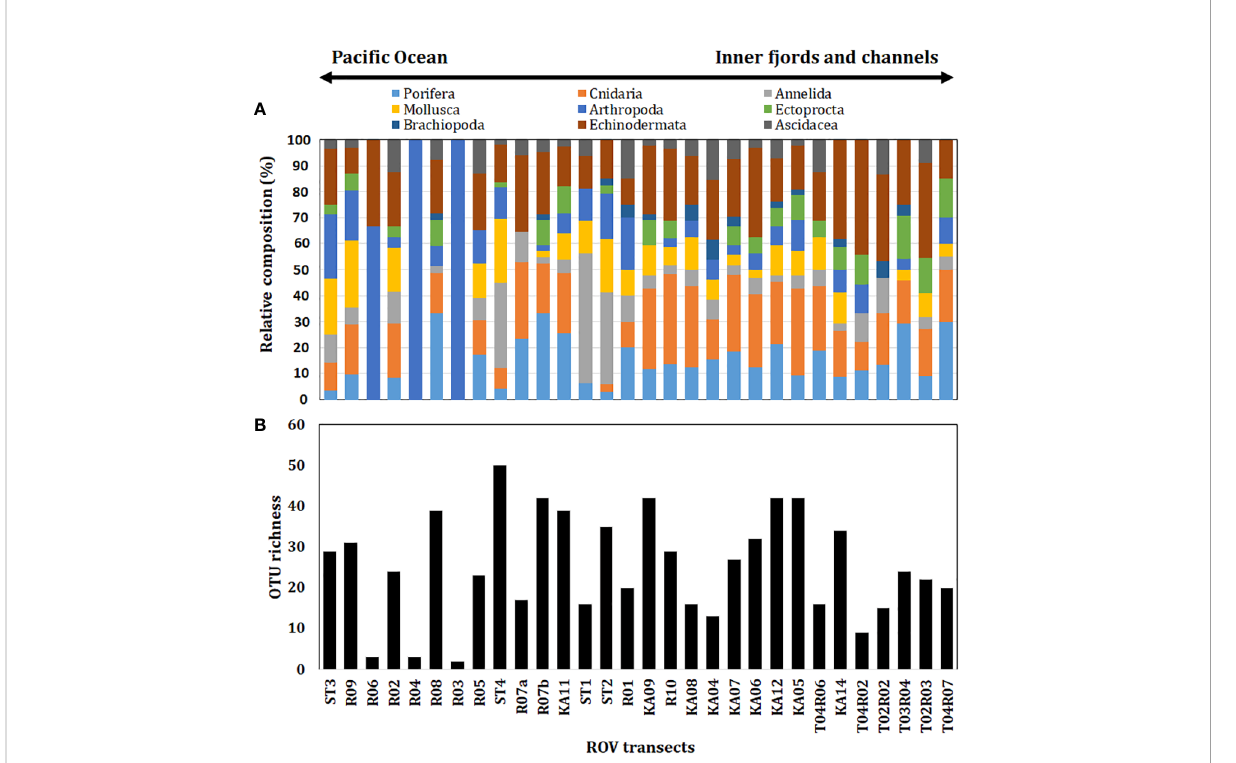
FIGURE 2 (A) Histogram of relative composition and (B) OTU richness of sublittoral benthic invertebrate assemblages in different ROV transects and SCUBA diving sampling across the KNR waters. Stations were ordered